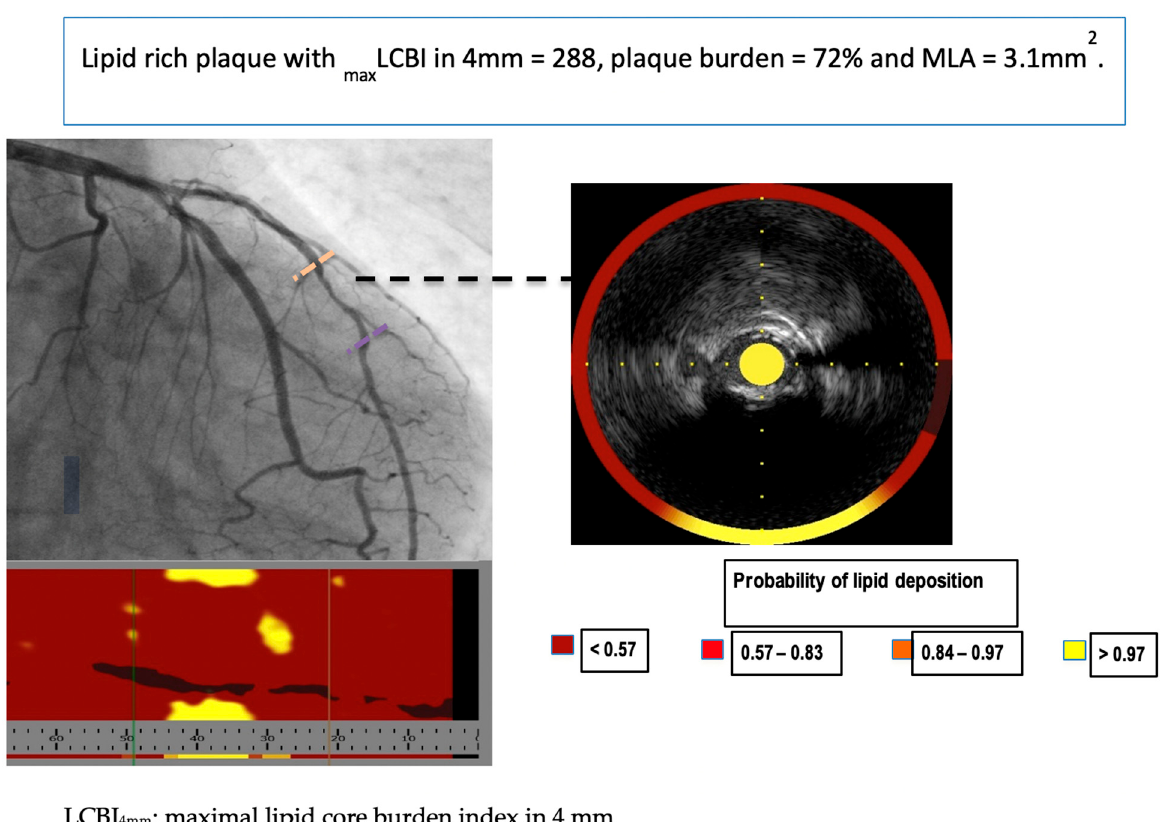
Figure 3. Representative image of near-infrared spectroscopy and intravascular ultrasound (NIRS- IVUS) of lipid-rich IVUS) of lipid-rich plaque.